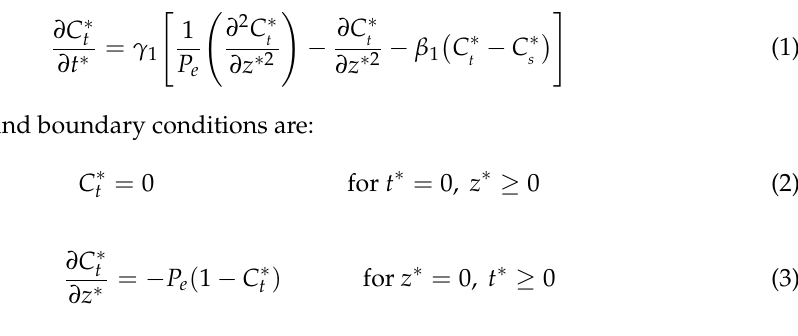
Figure 9. Adsorption of Cu ions on nanocellulose at di ff erent temperature levels.